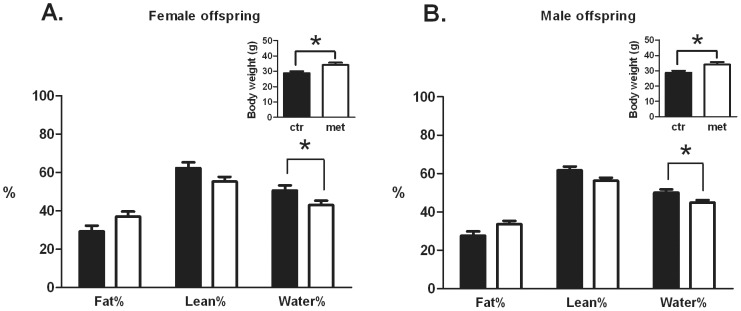
Body composition.